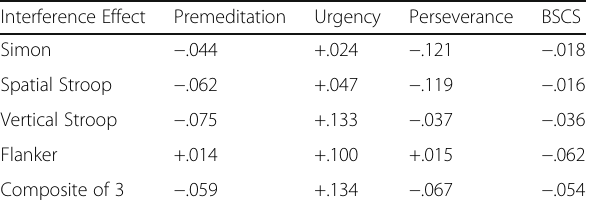
Table 6 Correlations between the four self-control/impulsivity scales and the individual task and composite interference effects based on RT